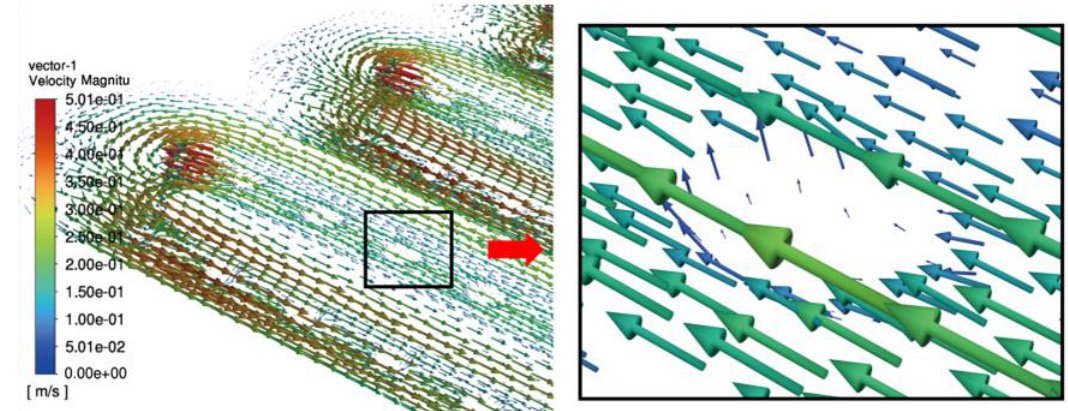
Figure 15. Flow vector diagram for the counterflow case in the BFS structure. Figure 15 . Flow vector diagram for the counterflow case in the BFS structure.